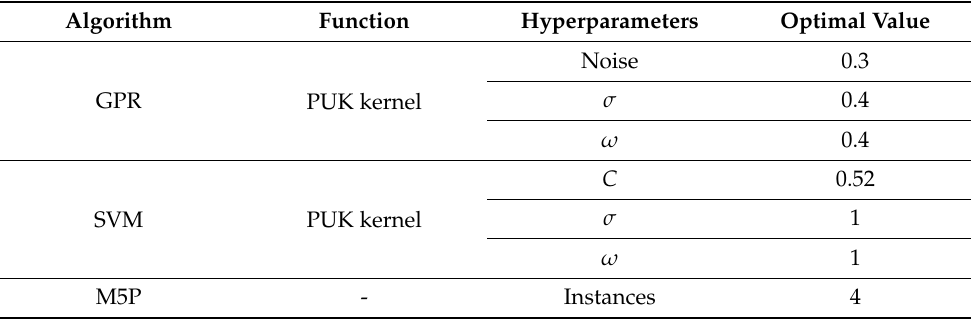
Table 3. Optimized